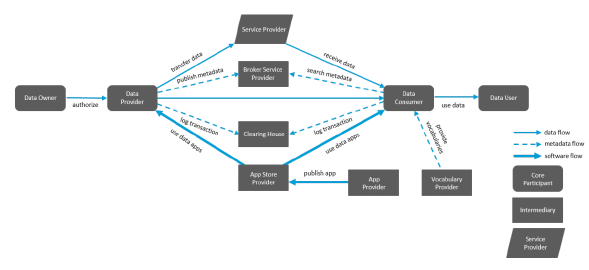
Figure 3. IDS system role